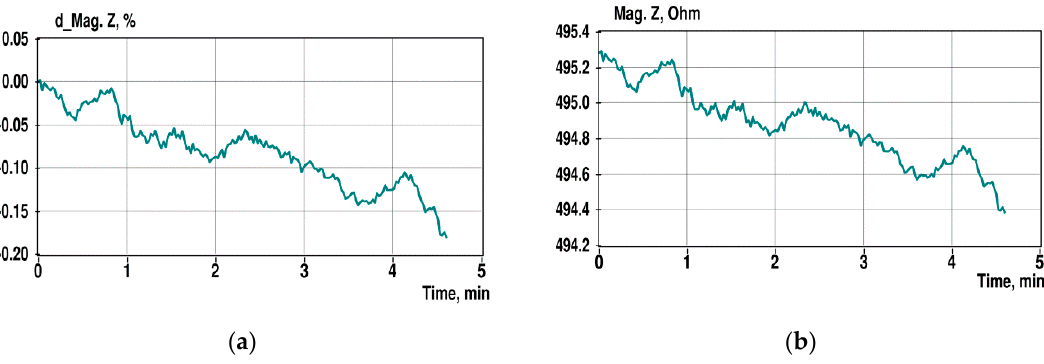
Figure 15. Relative ( a ) and absolute ( b ) value changes of the impedance magnitude at 10 kHz during 5 min observation. Additional moving average filtration is used to suppress high-speed fluctuations.